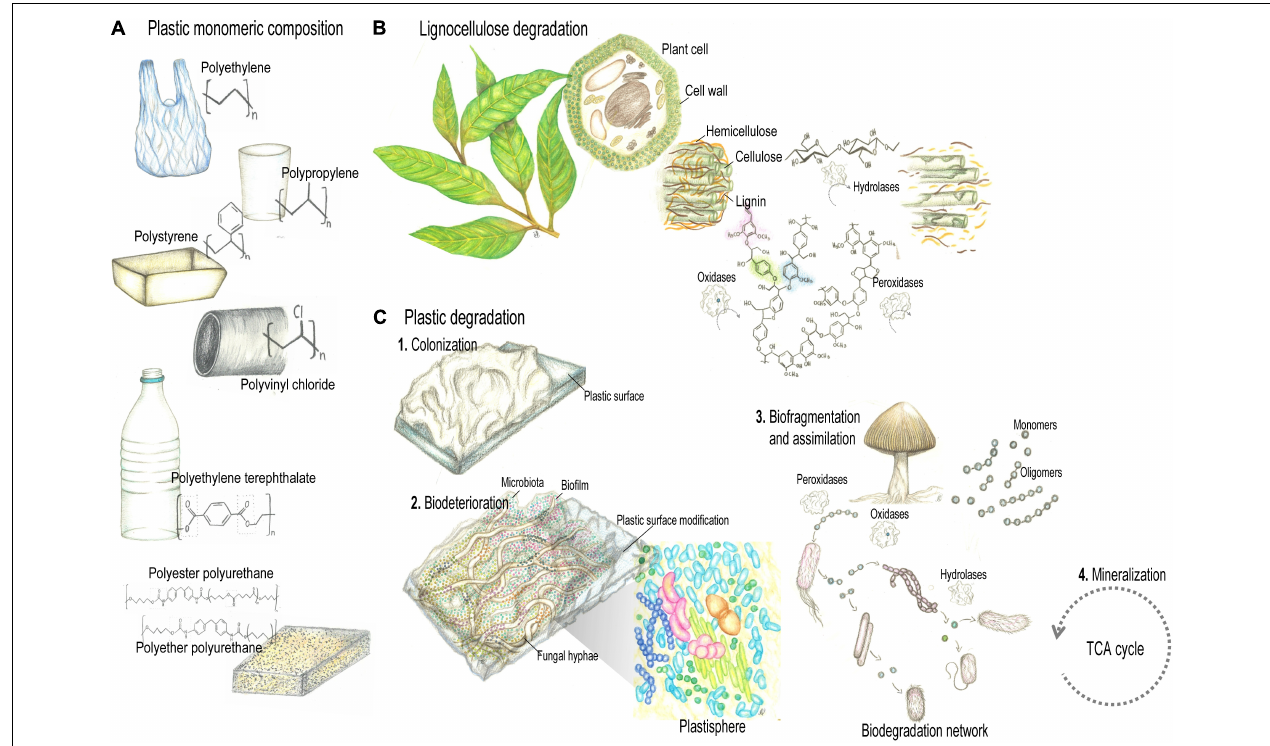
FIGURE 1 | Plant and synthetic polymers degradation (A) . Petroleum-derived polyethylene (PE), polypropylene (PP), polystyrene (PS), polyvinylchloride (PVC), polyurethanes (PUR), and polyethylene terephthalate (PET) comprise the majority of plastic polymers currently produced. (B) Despite fundamental differences regarding structure and recalcitrance, lignocellulose and plastic polymers share physical-chemical properties to some extent, that include carbon skeletons with similar chemical bonds, hydrophobic properties, amorphous and crystalline regions. Thus, microbial strategies to deal with such properties would allow enzymes with lignocellulolytic activity to depolymerize plastics. (C) Plastic biodegradation encompasses processes of bio-deterioration and bio-fragmentation. Enzymes active during the biodegradation of synthetic plastic polymers include hydrolases and oxidoreductases. Pencil drawing illustrations by Mariana